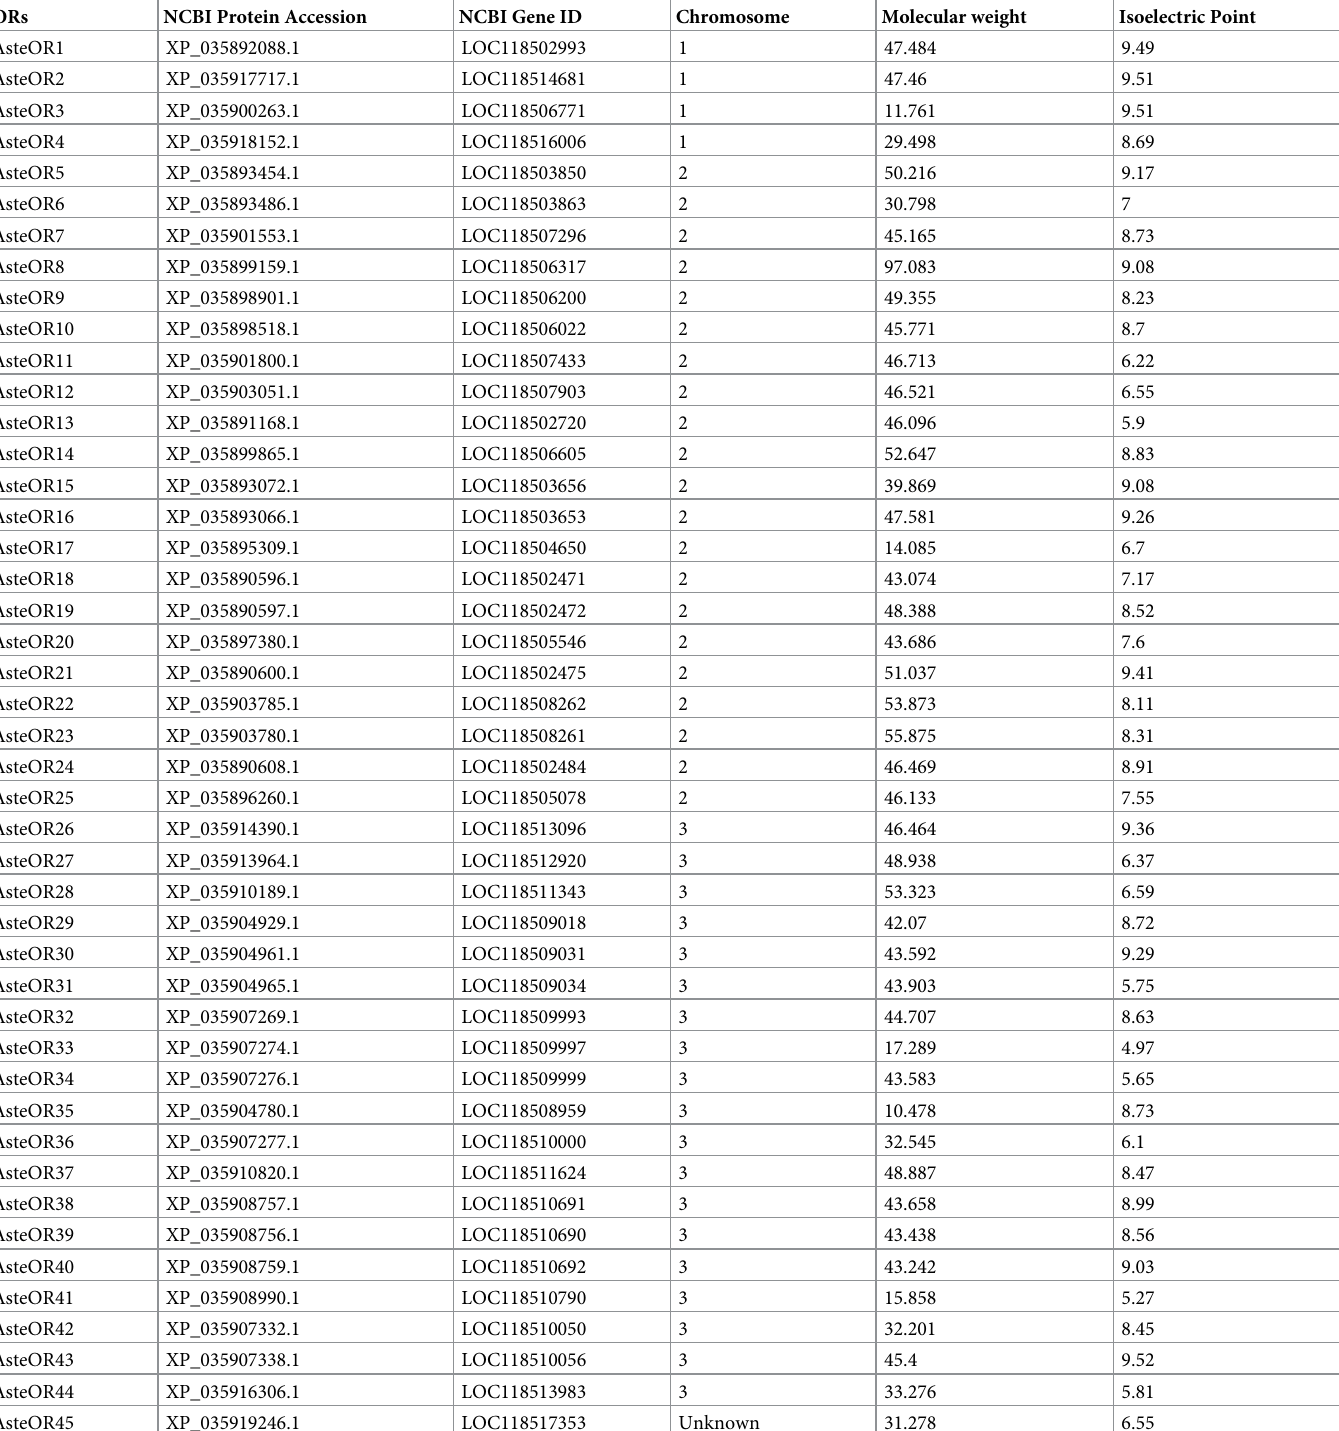
Table 2. Renaming of odorant receptor (ORs) and